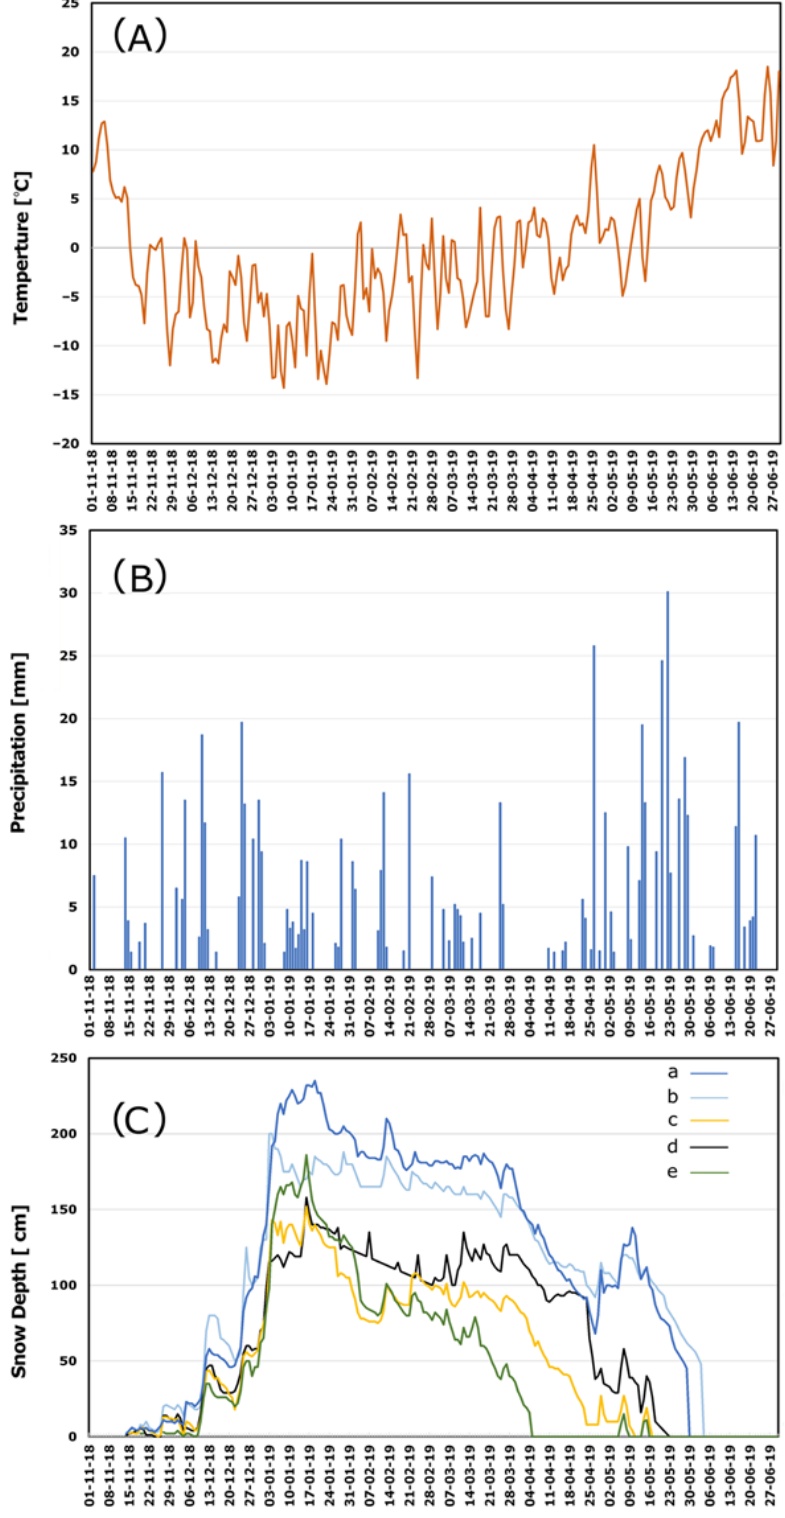
Figure 2. Weather conditions in the Tatras during the 2018/2019 research season: ( A ) air temperature (meteorological station in the Dolina Pięciu Stawów Polskich), ( B ) daily precipitation amounts (meteorological station in the Dolina Pięciu Stawów Polskich), ( C ) snow cover thickness (meteorological stations: a — on the Kasprowy Wierch; b —in the Dolina Pięciu Stawów Polskich ; c — on the Hala Gąsienicowa ; d — in the Dolina Rybiego Potoku by the Morskie Oko mountain shelter; e — on the Polana Chochołowska).